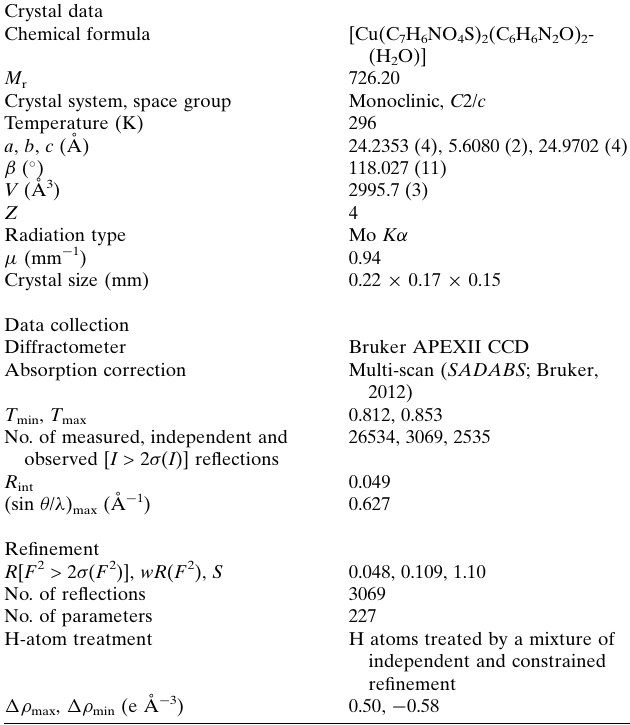
Table 2 Experimental details. Crystal data Chemical